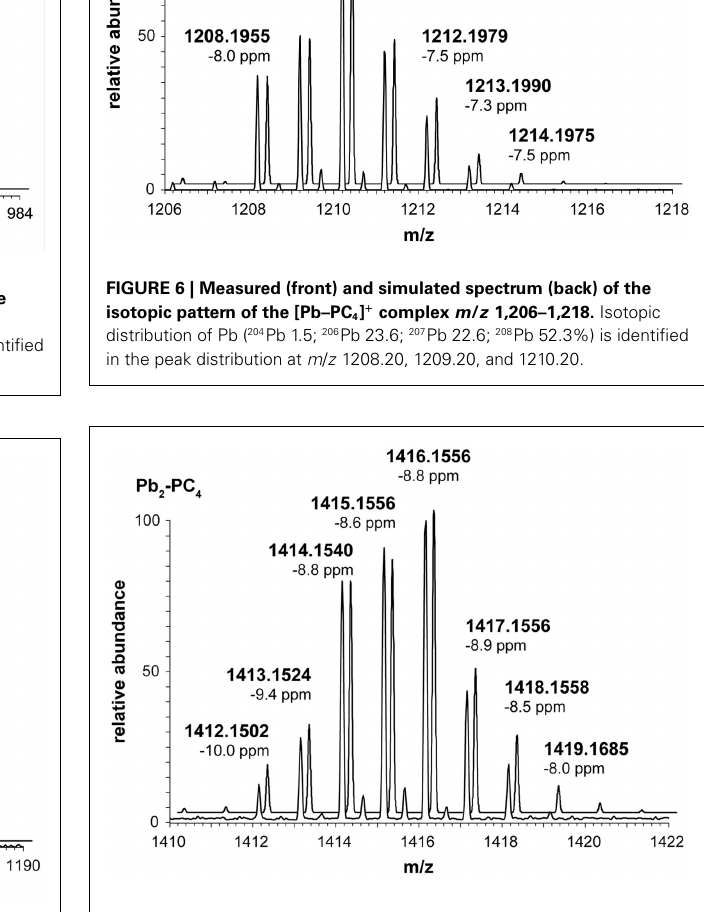
FIGURE 7 | Measured (front) and simulated spectrum (back) of the isotopic pattern of the [Pb 2 –PC 4 ] + complex m / z 1,410–1,422.